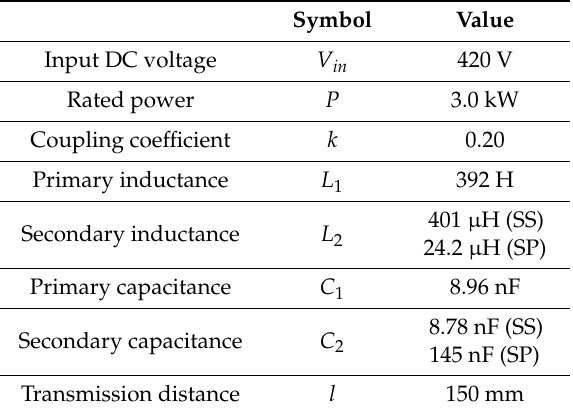
Table 1. Specifications of prototype.